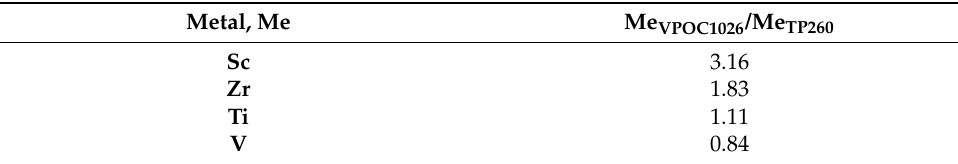
Table 4. Ratios of metal’s capacity in VP OC 1026 resin to TP 260 resin.